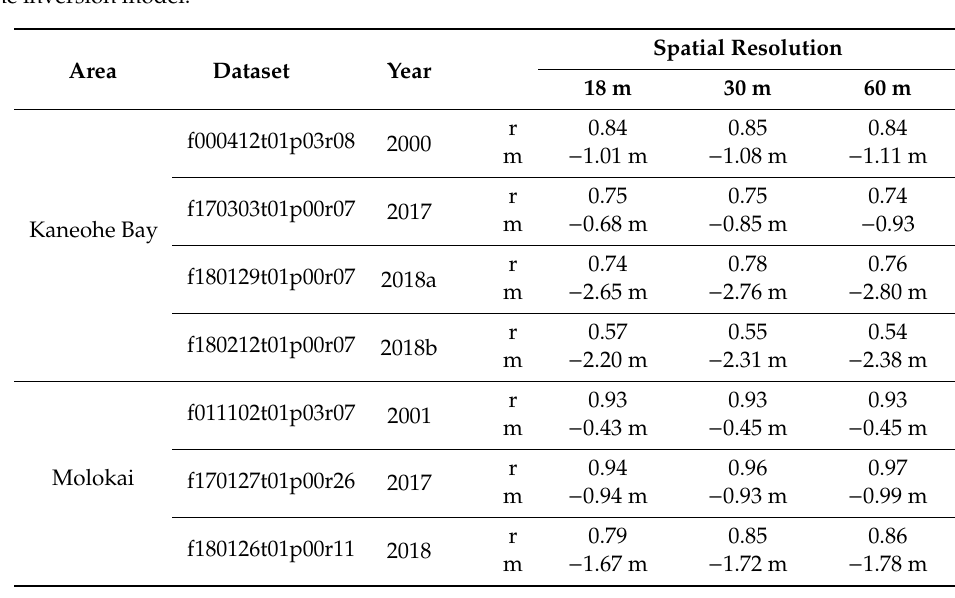
Figure 4. Scatterplots of hyperspectral derived bathymetry compared to lidar bathymetry for Kaneohe Bay and Molokai at 18 m spatial resolution, showing relative point density; with linear correlation coefficient, r, and mean difference, m, for depth range from 0–15 m. Table 2. Statistical comparison of hyperspectral derived bathymetry compared to lidar bathymetry for Kaneohe Bay and Molokai at di ff erent spatial resolutions; with linear correlation coe ffi cient, r, and mean di ff erence, m, for depth range from 0–15 m. Negative m values indicate underestimations of depth by the inversion